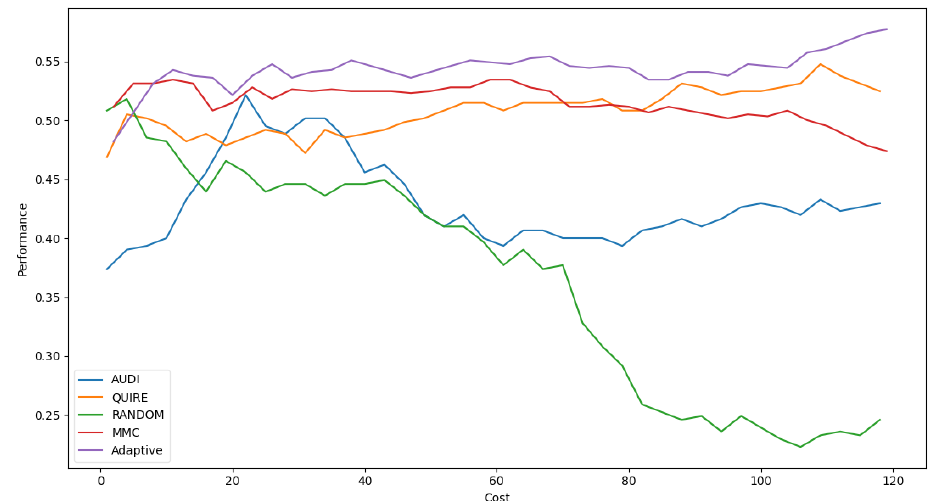
Figure 5. Classification accuracy for the five selection AL strategies without grid search optimizer.